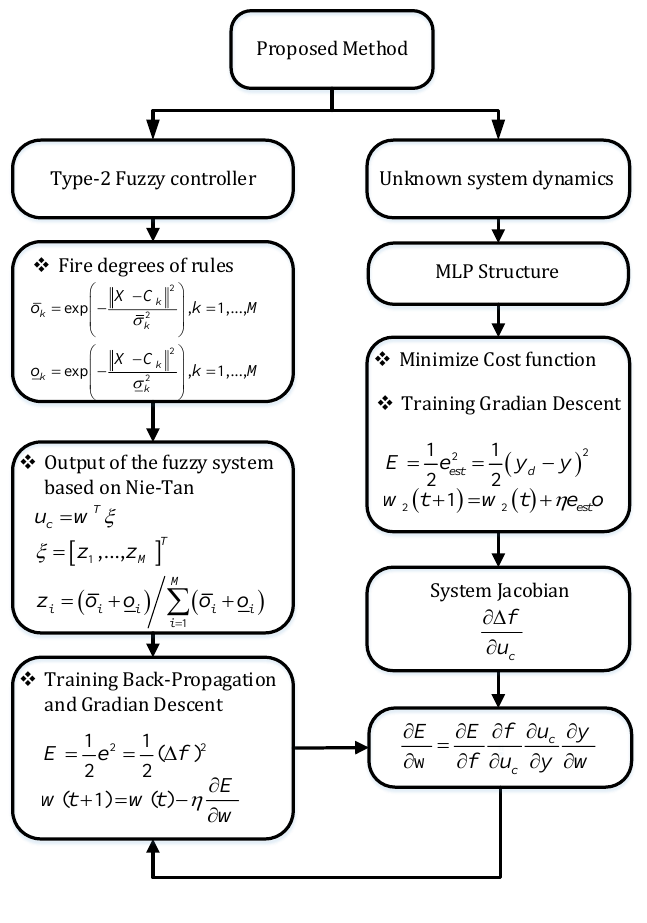
Figure 4. The flowchart of the proposed